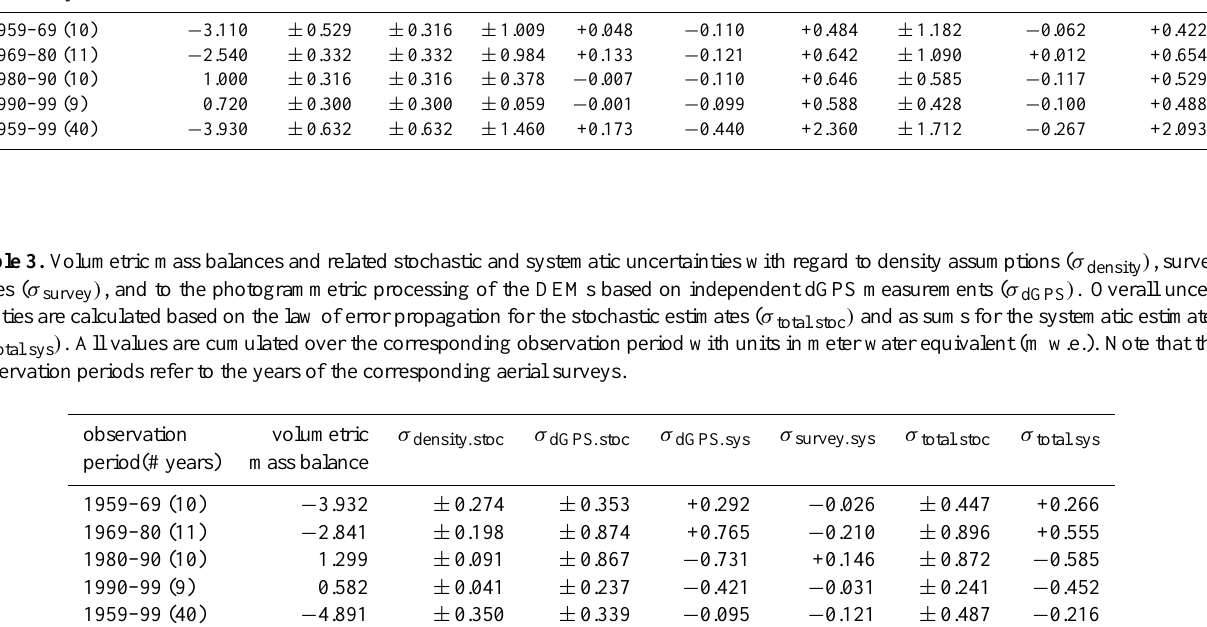
Table 2. Cumulative glaciological mass balances and related stochastic and systematic uncertainties with regard to field measurements ( σ field ) , interpolation methods ( σ krig ) , reference areas ( σ ref ) , internal ablation ( σ intAbl ) and accumulation ( σ intAcc ) . Overall uncertainties are calculated based on the law of error propagation for the stochastic estimates ( σ total . stoc ) and as sums for the systematic estimates ( σ total . sys ) ; the latter including and excluding uncertainties for internal accumulation. All values are cumulated over the corresponding observation period with units in meter water equivalent (mw.e.). Note that the observation periods refer to the start and end year of the corresponding first and last field surveys, respectively, e.g., the period 1959–99 covers the hydrological years from 1959/60 to 1998/99. observation cum. glac.